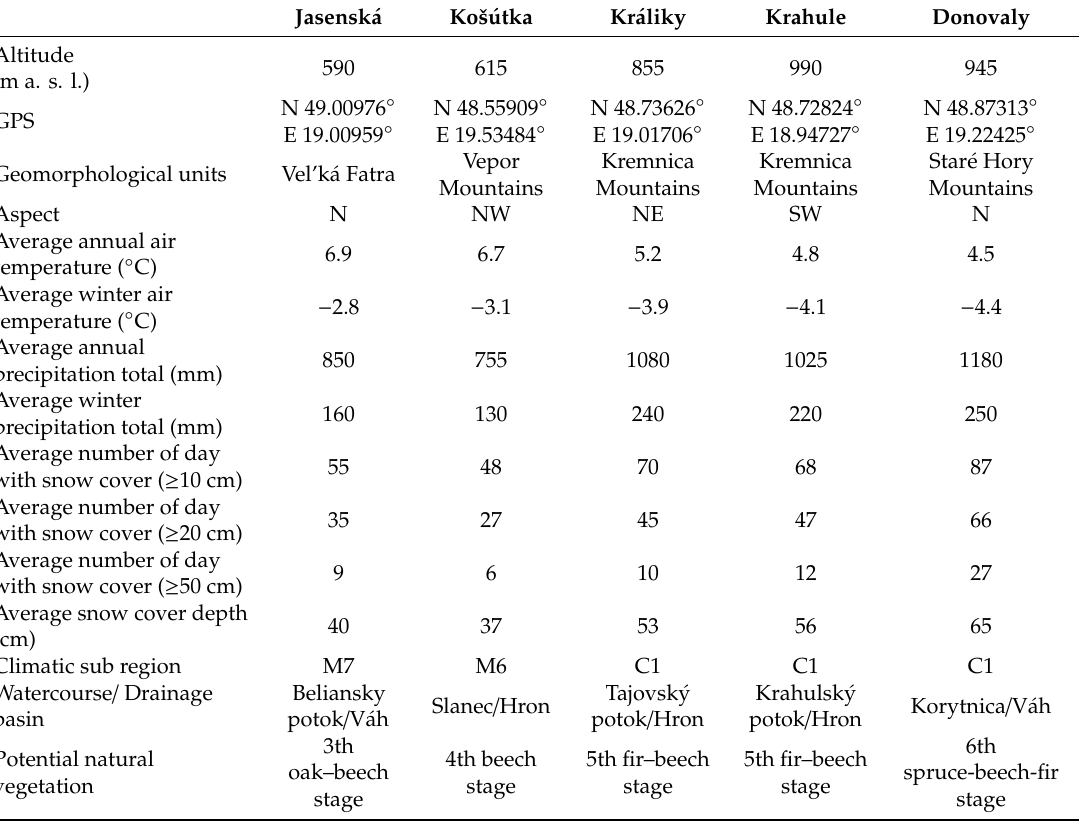
Table 1. The basic environmental characteristics of five ski centers in Central Slovakia at which the snow density was examined, according to the Climate Atlas of Slovakia [36] where data from 1961 to 2010 were processed.